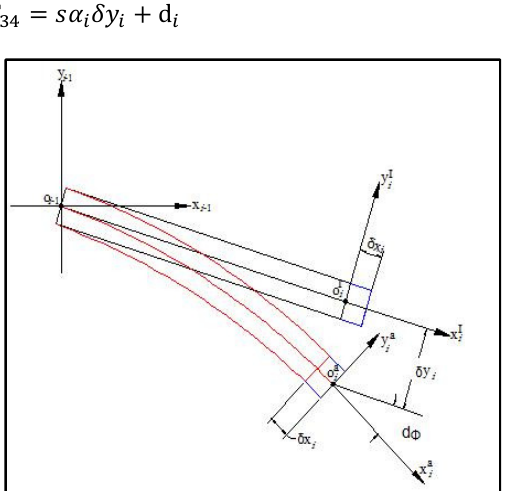
Fig. 3. The coordinates system of a single flexible link under